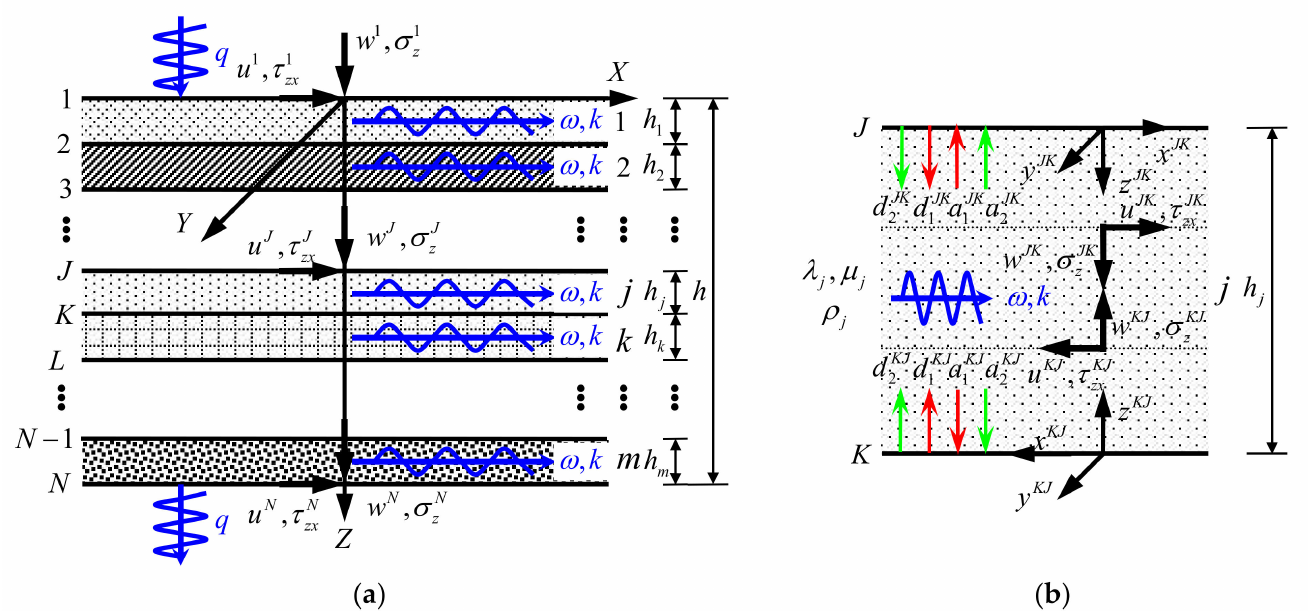
Figure 1. The schematic of a general periodically multilayered isotropic media: ( a ) The unit cell, its global coordinate system, and the physical quantities of surfaces/interfaces; ( b ) the local dual coordinate systems and the physical quantities of a typical layer j